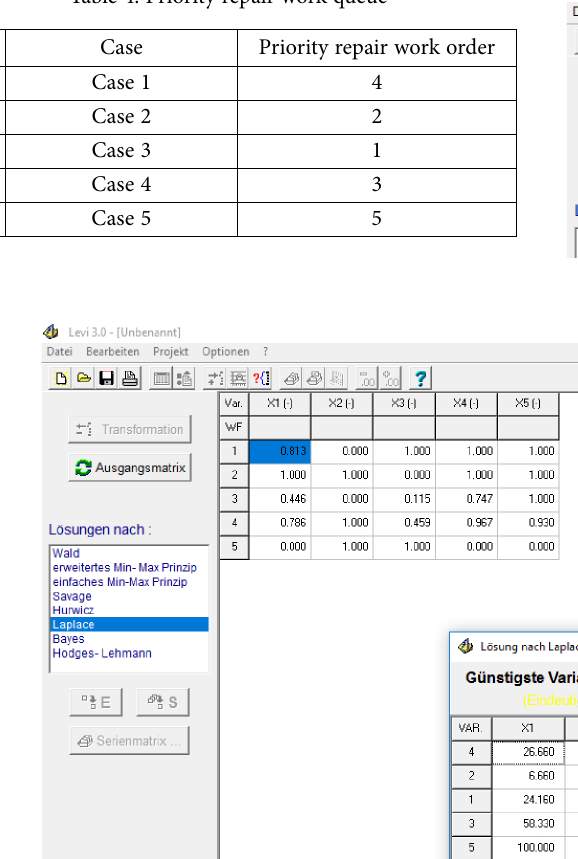
Figure 6. Results were obtained according to the Laplace’s